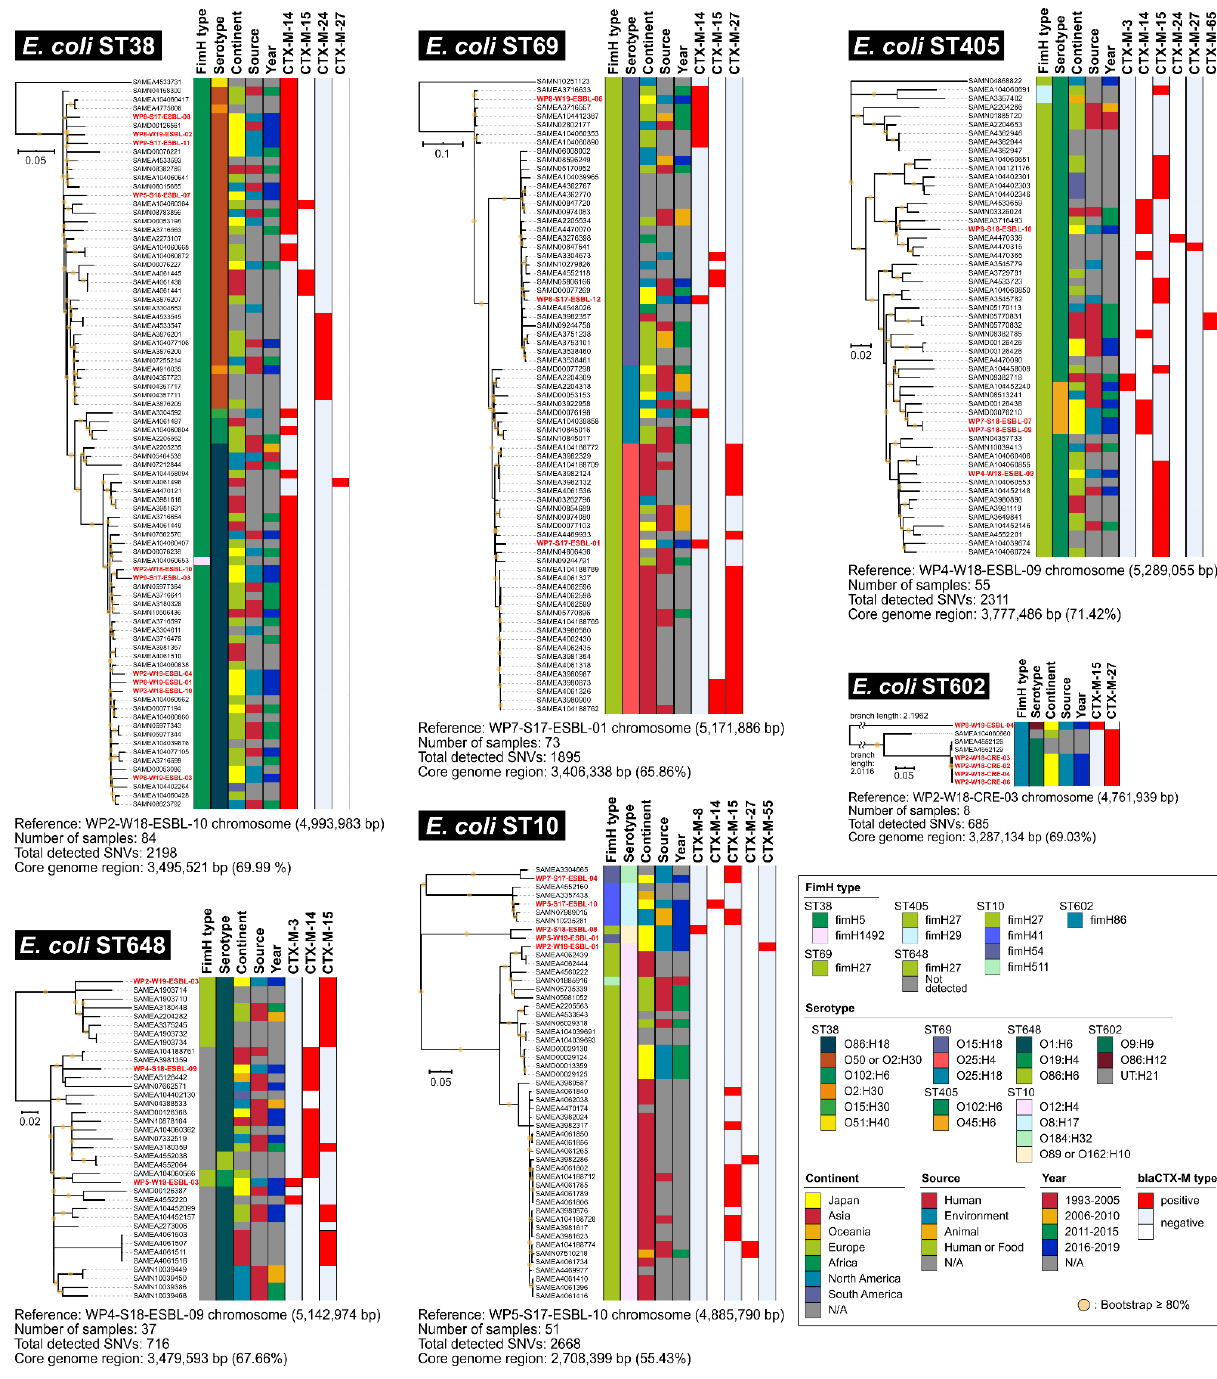
Figure 4 . Core genome SNV phylogeny of other E. coli ST isolates from WWTP effluents. Isolates in this study was highlighted by red in the strain name (see detail in Tables S2 and S3). For instance, all E. coli ST38 isolates ( n = 10) were ST38- fimH5 - and CTX-M-14-posi- With respect to E. coli ST405 ( n = 4 isolates), most ST405 isolates, including publicly tive. However, these were classified into different serotypes (O86:H18 and O50/O2:H30), available genomes, exhibited O102:H6-ST405- fimH27 and carried multiple CTX-M types. Two isolates (WP7-S18-ESBL-07 and WP7-S18-ESBL-09) exhibited distinct serotypes O45:H6 from other ST405 isolates. These two isolates showed the most similar genome SNV profile as SAMD00126438 (Human in Japan, Table S4) and SAMD00076210 (sewage in Japan, Table S4), suggesting that CTX-M-14-positive O45:H6-ST405- fimH27 E. coli isolate could be notable in Japan (Figure 4, panel